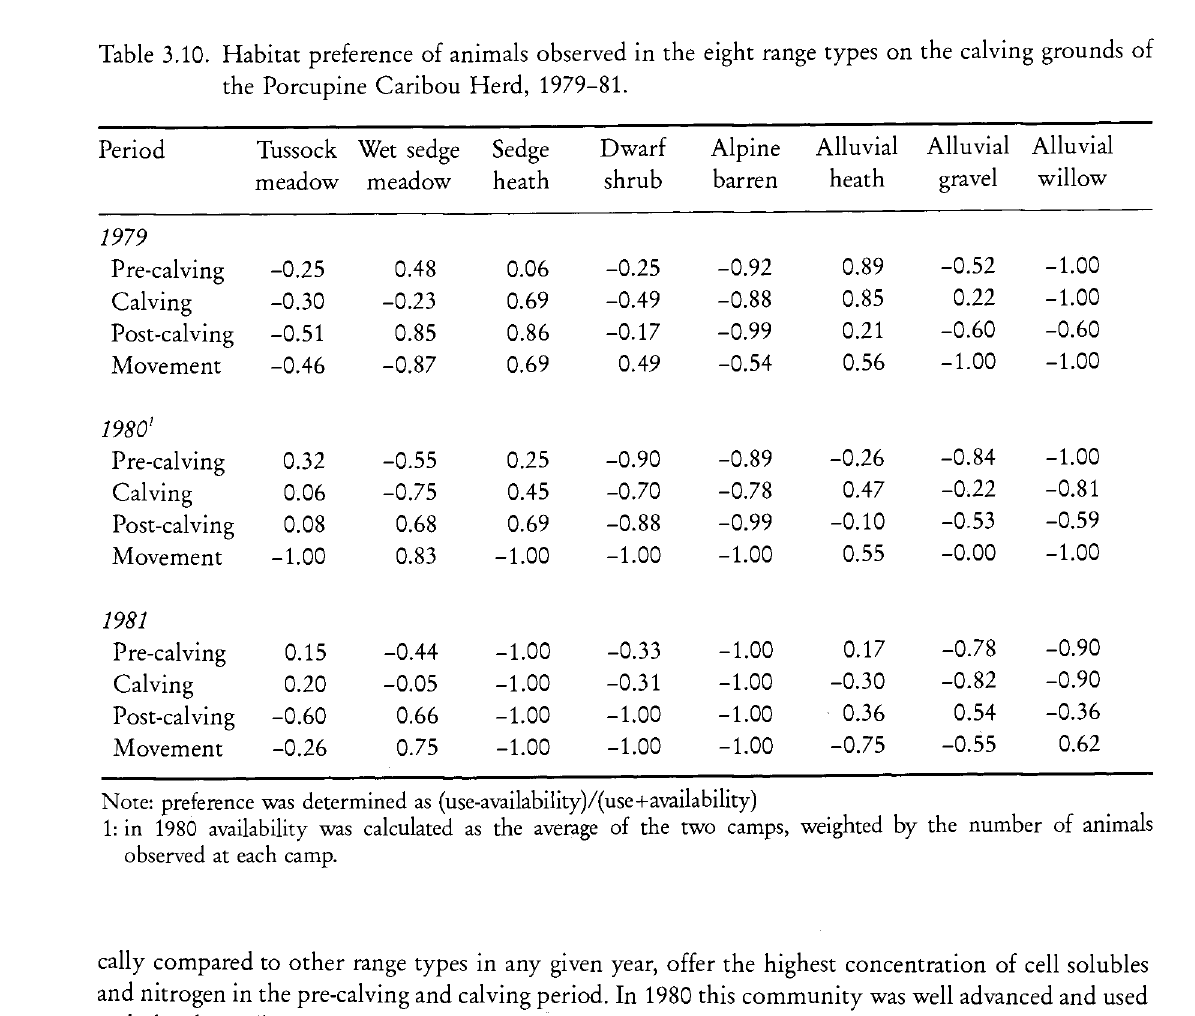
Table 3.10. Habitat preference of animals observed in the eight range types on the calving grounds of the Porcupine Caribou Herd,